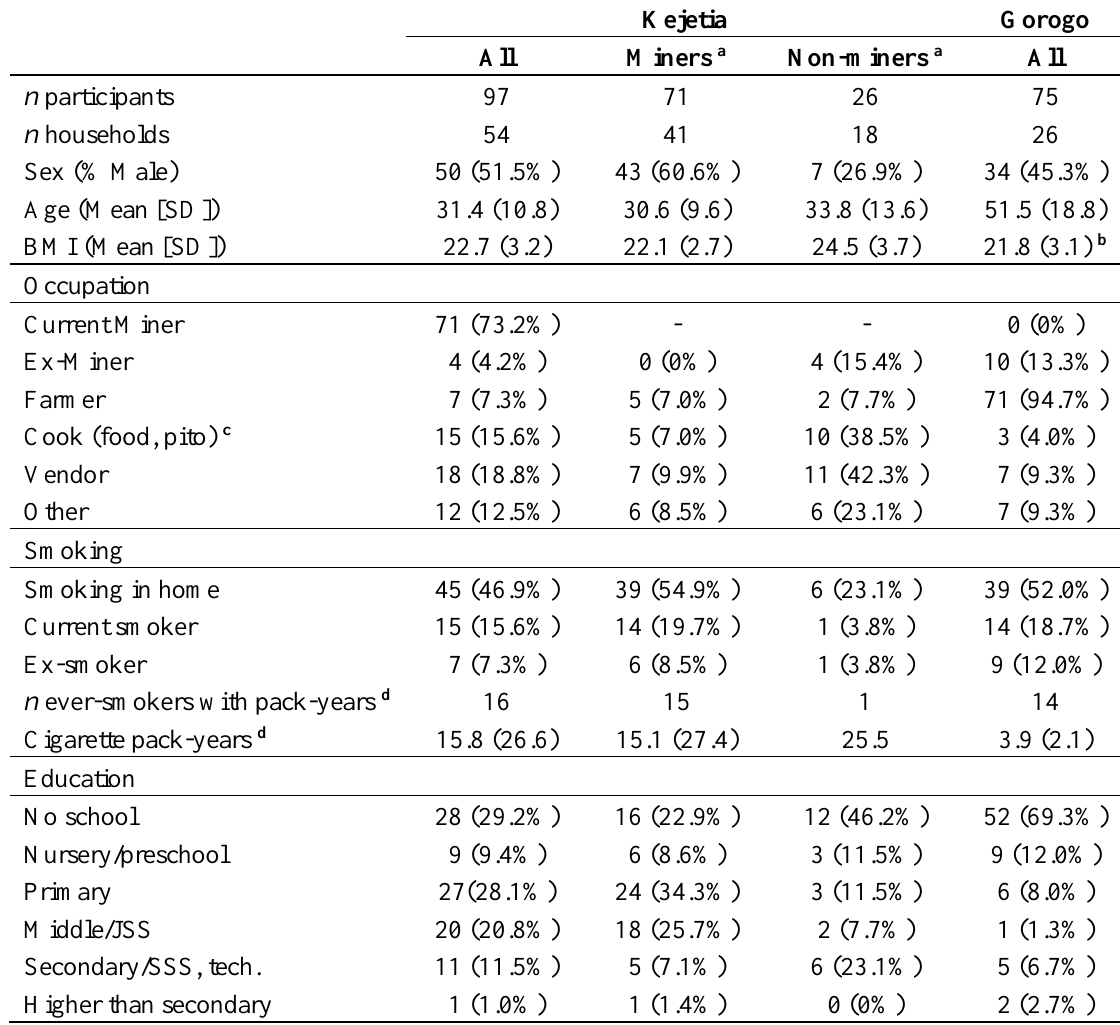
Table 1. Demographic information of Kejetia and Gorogo